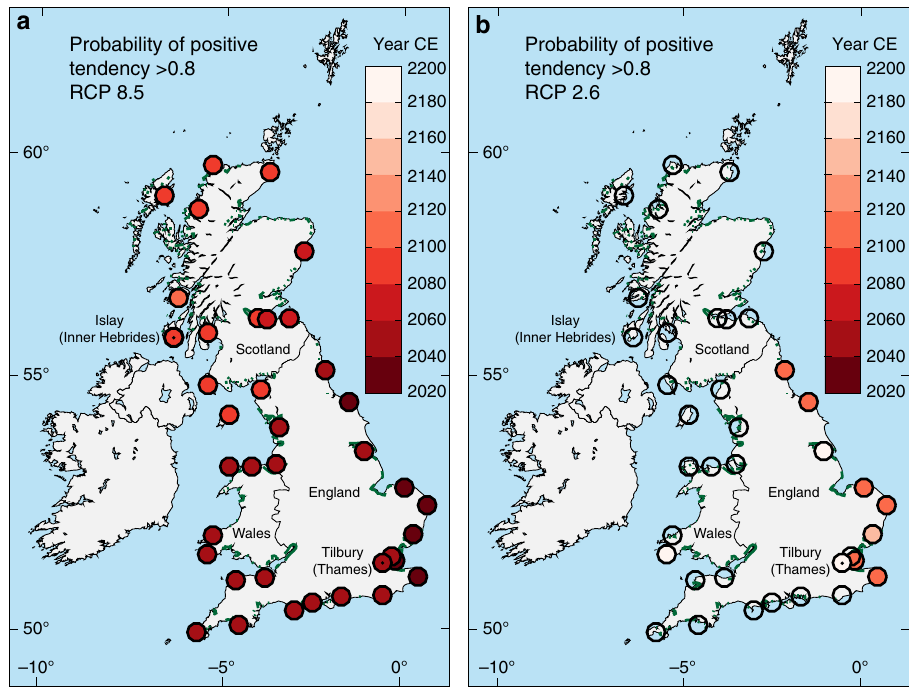
Fig. 3 Probability for a positive sea ‐ level tendency under different emission pathways. Maps of selected locations in Great Britain showing the year of probability P > 0.8 for a positive sea ‐ level tendency under a high ‐ emission Representative Concentration Pathway (RCP) 8.5 and b low ‐ emission RCP 2.6 pathways. Current areas of tidal marshes (in green) following ref. 51 . Tilbury and Islay are highlighted (black dots in